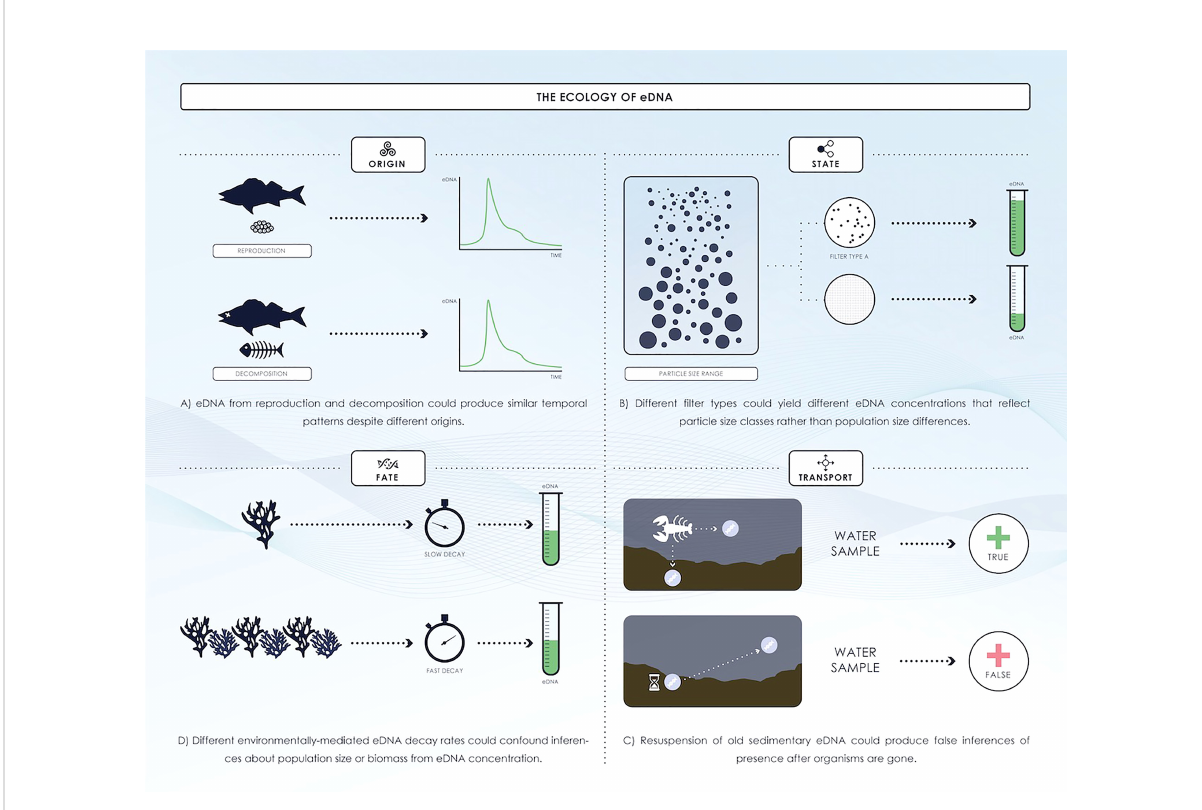
FIGURE 3 eDNA ecology affects population inferences: Origin, State, Fate and Transport (redrawing from Barnes and Turner,